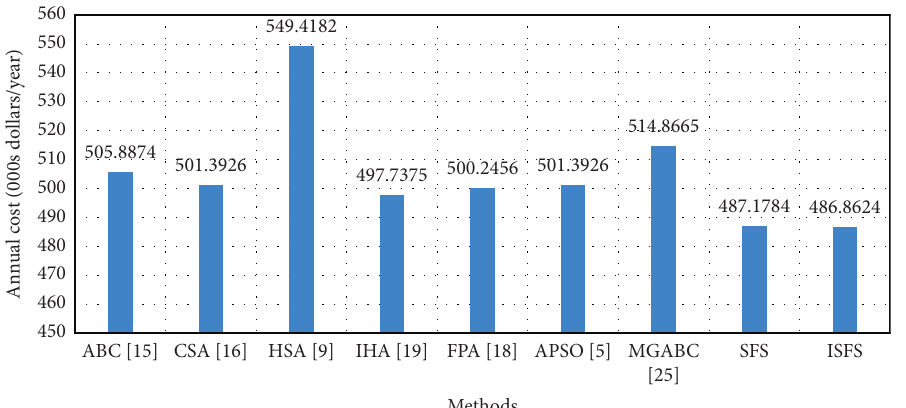
Figure 17: Comparison of minimum annual costs obtained by different methods for 119-bus network.